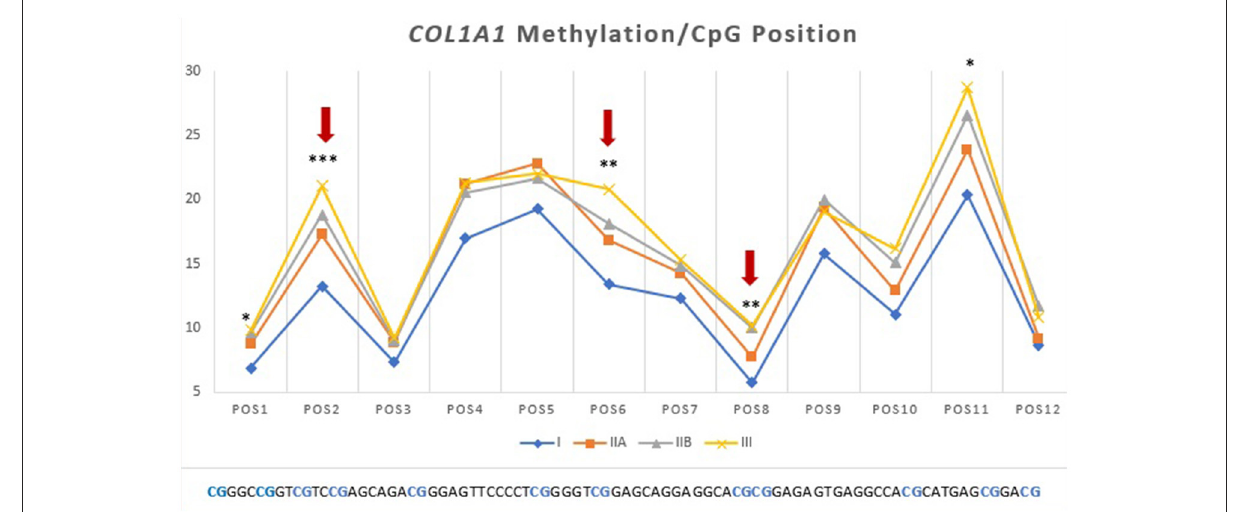
FIGURE7 Methylation (%) of COL1A1 by CpG position in equine endometrial categories graded as Kenney and Doig’s classification. Red arrows and asterisks indicate significant differences between CpG positions (* P < 0.05, ** P < 0.01, *** P < 0.001).